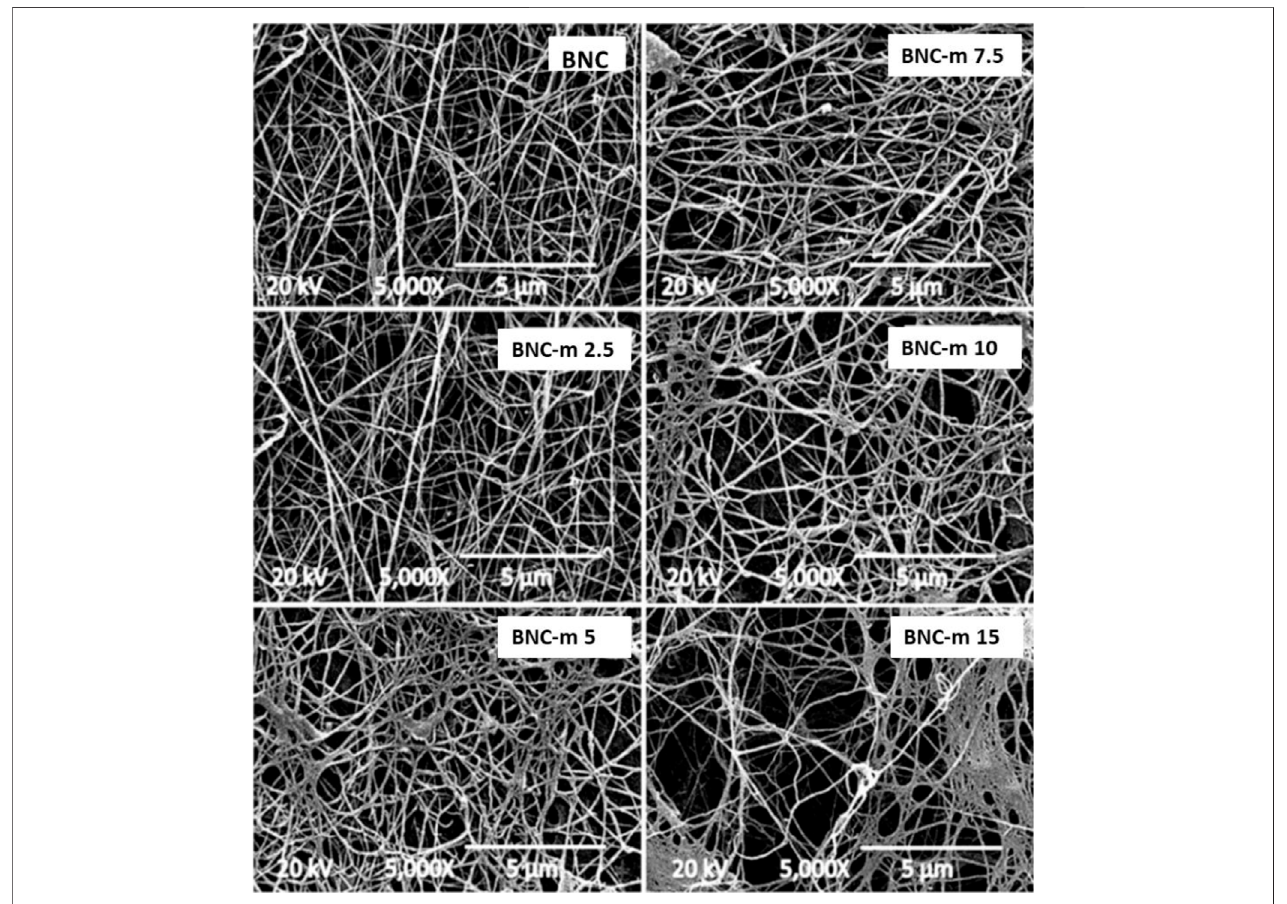
FIGURE 5 | SEM micrographs at